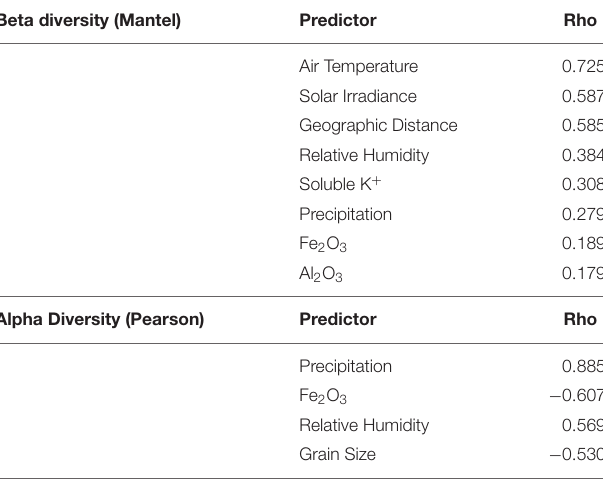
TABLE 1 | Significant correlations ( p < 0.01) of abiotic variables with prokaryotic alpha and beta diversity using Pearson and Mantel